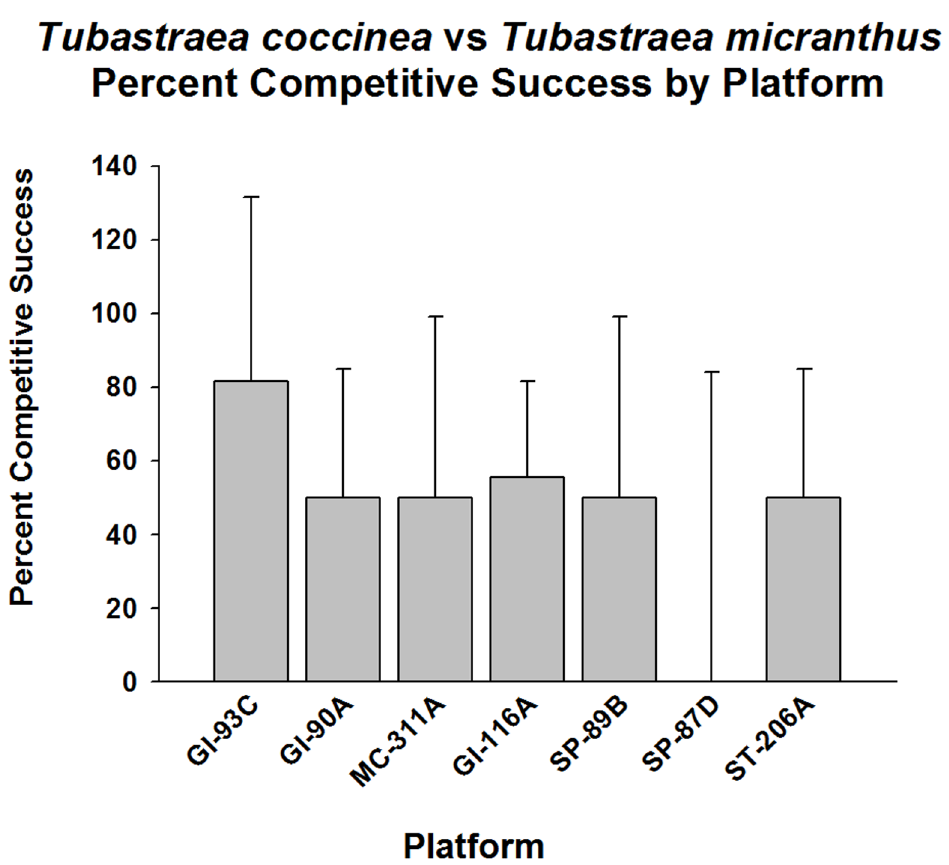
Fig 5. Percent of successes in competition for space between Tubastraea coccinea vs. T . micranthus . Here, T . coccinea was the target organism. Data presented by platform. Mean plus 95% confidence limits shown. Range of number of interactions per platform (n): 6 – 155. See Fig 2 legend for additional details. Overall competitive success significantly greater than 50% (p < 0.001, Fisher ’ s Exact Test). Significantly higher frequency of competitive successes on GI-93C than on other platforms (p < 0.001, Goodness of Fit Test, G-statistic) where competitive success frequency did not differ significantly from a 50% competitive success level (p >